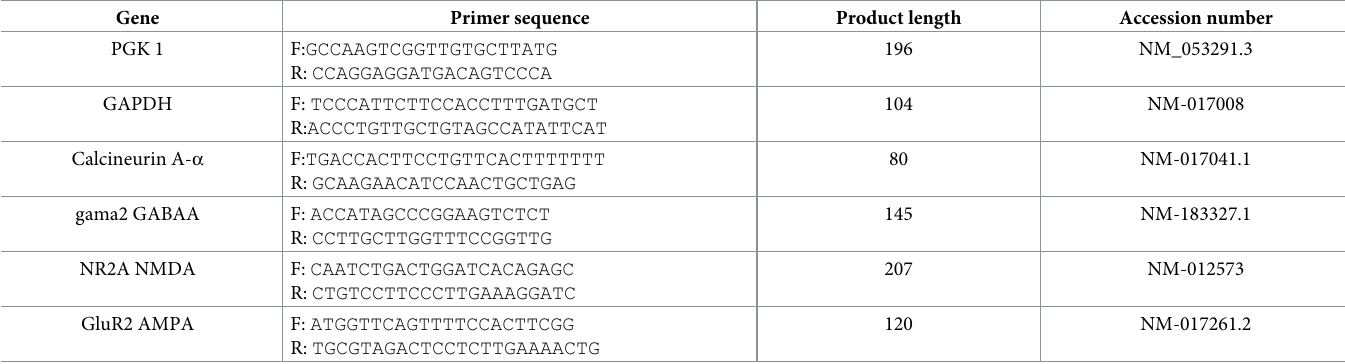
Table 1. Sequences of primers used in real-time polymerase chain reactions.